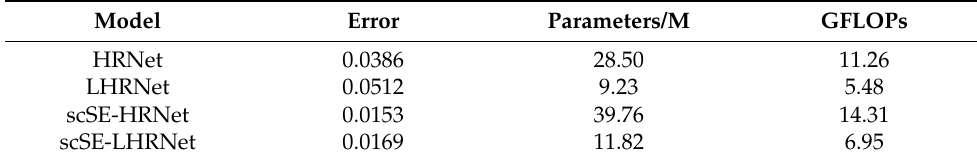
Table 2. Comparison results of ablation experiment.